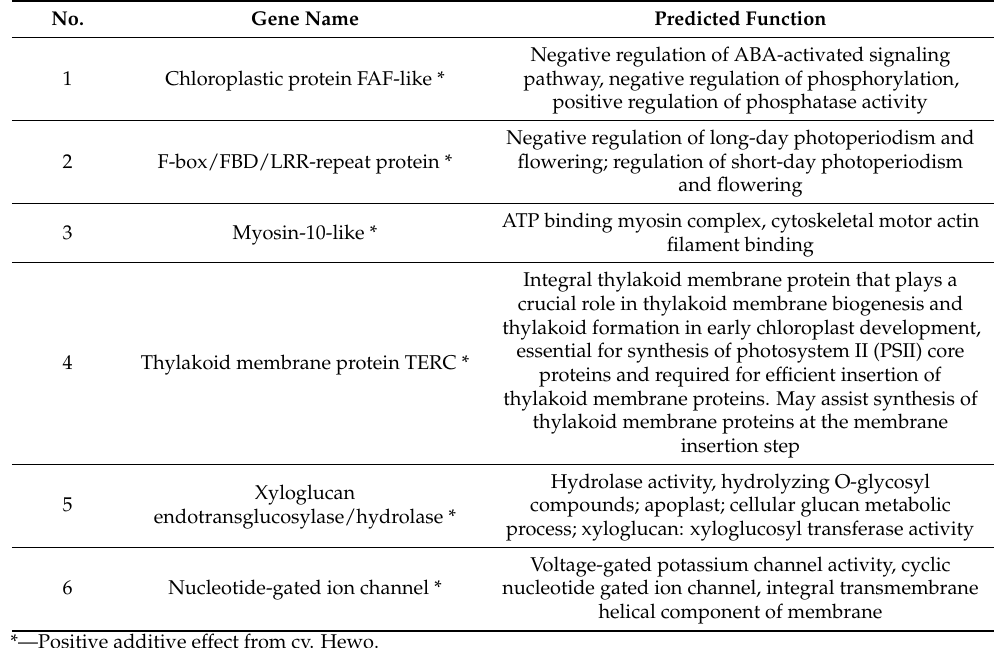
Table 2. Candidate genes in silico identified within 0–37 cM region of chromosome 5R in DH Hewo × Magnat winter triticale population.